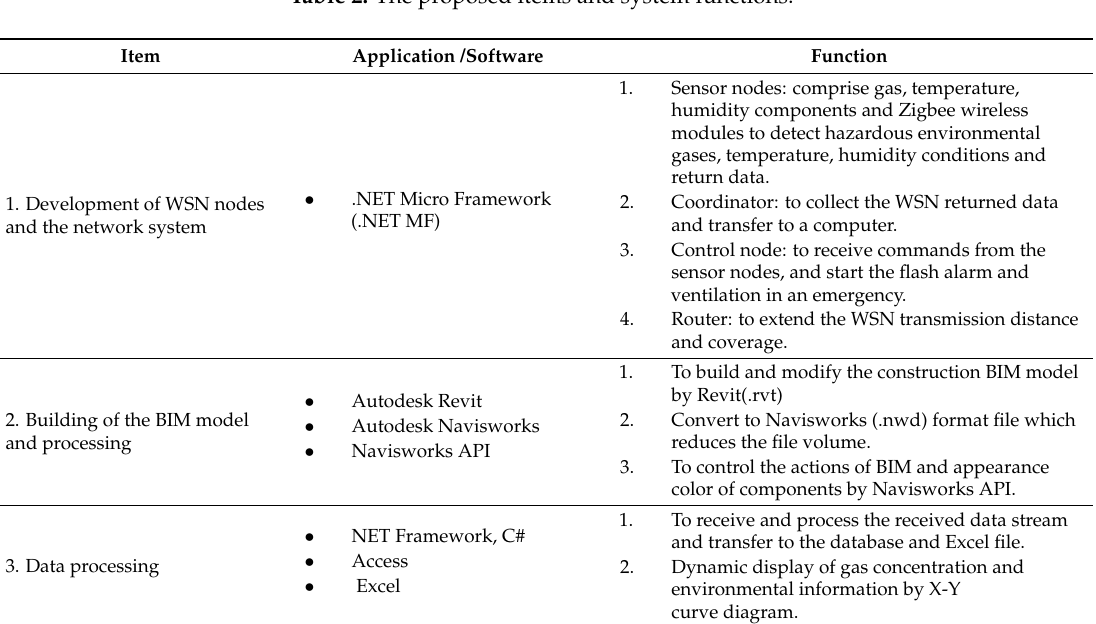
Figure 3. The system relationship and adopted applications. Table 2. The proposed items and system functions.